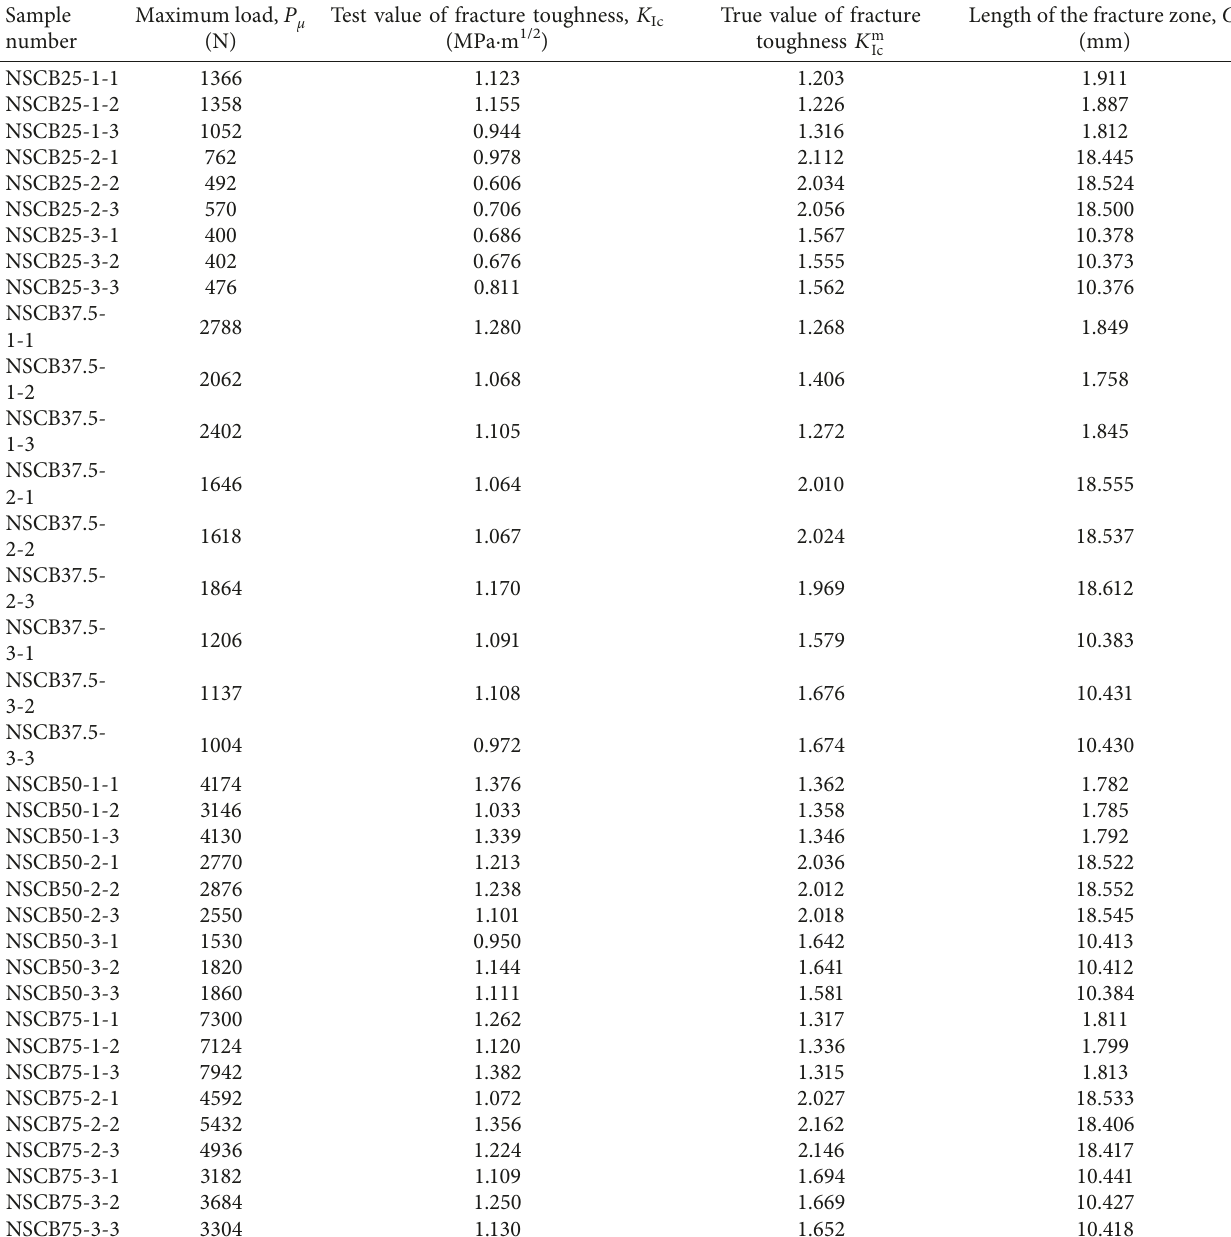
Table 2: Analysis data of the NSCB